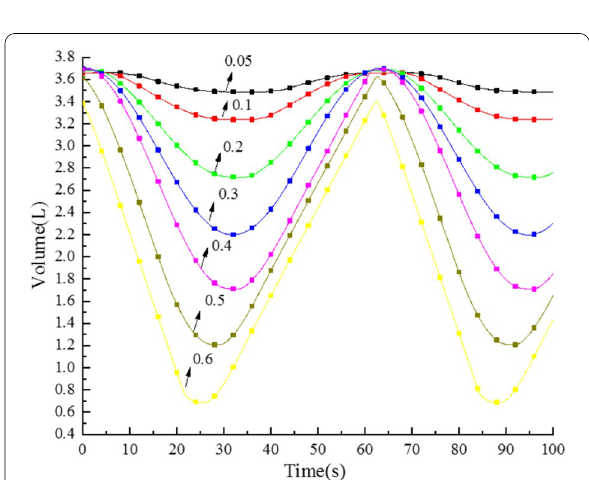
Figure 28 Changes in volume at different volume ratios